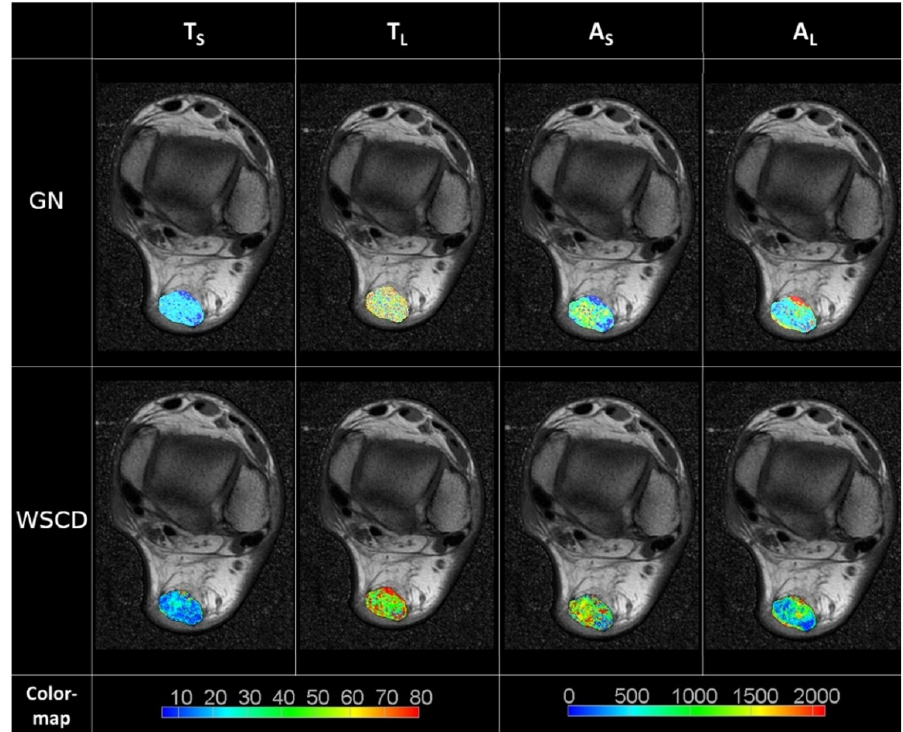
Figure 6. Comparison of biexponential reconstructions based on the GN and WSCD methods with the true T S , T L , A S , and A L maps. True maps were used to create simulated intensity signals from which the biexponential reconstructions were obtained. The noise level was set to 100 and was normally distributed. The reconstruction maps were affected by noise; however, the WSCD method proved to be more accurate.